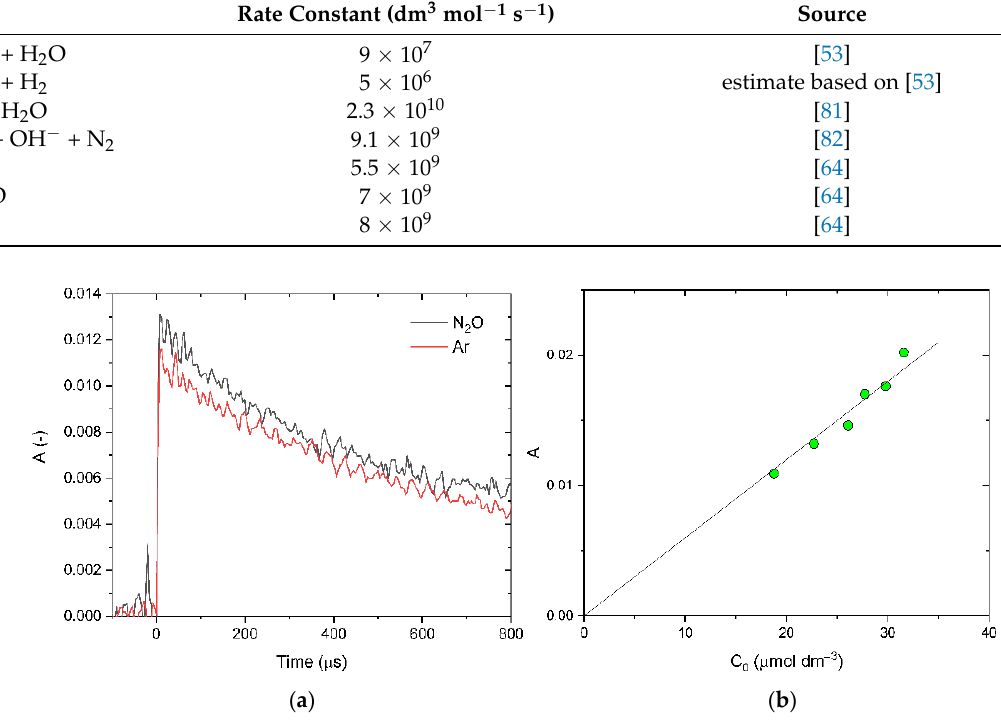
Table A1. Reactions and their rate constants used in the Kinetiscope simulations aimed at determination of radiation- chemical yield of PAA radicals at various experimental conditions. Reaction